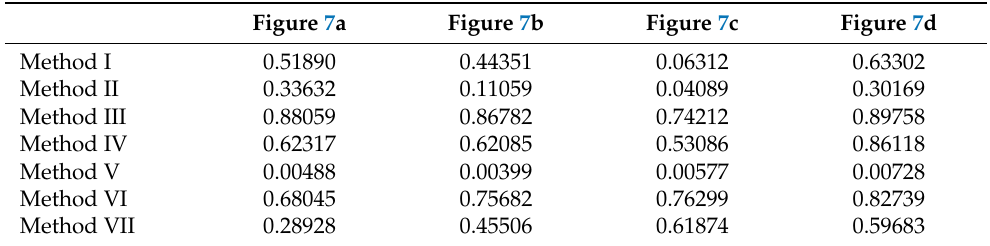
Table 7. Differences between the maximum and minimum values calculated according to (2), (8), (11), (14), (22), (26), and (28).